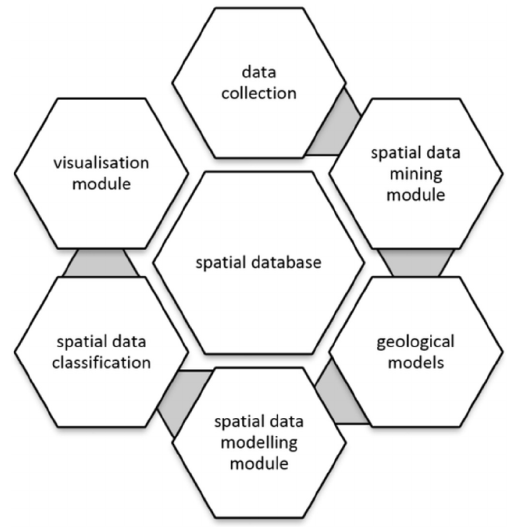
Figure 1. General structure of the deformation information